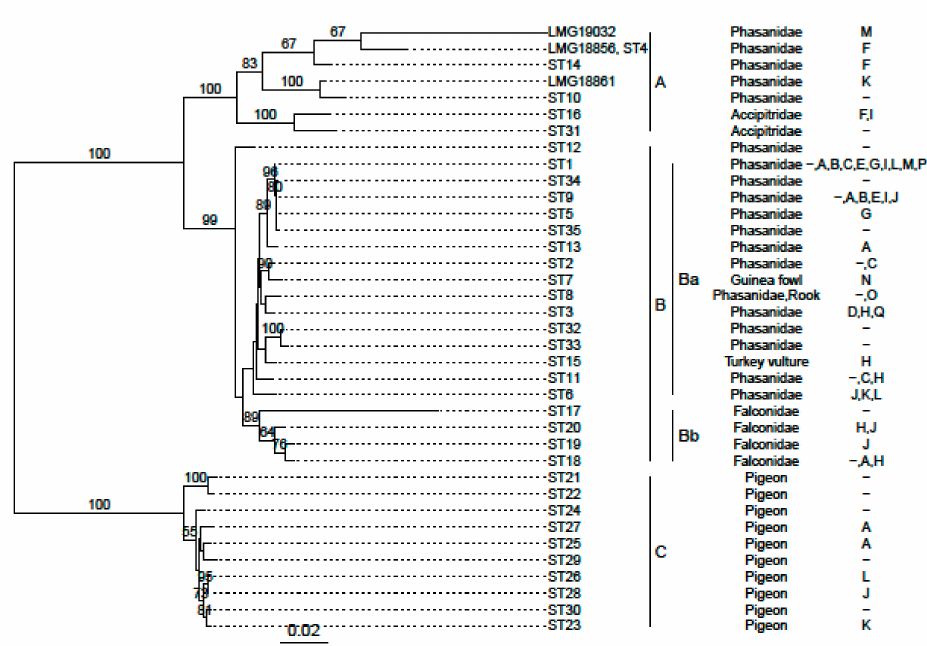
Figure 6. Maximum likelihood tree constructed from the concatenated sequences of the genes used for MLST using RAxML with a general time-reversible model with gamma-distributed rate variation and 1000 bootstraps. Bootstrap values greater than 50 percent are shown on branches. At the tips, either the sequence type (ST) or the strain name is given, followed by the host and the determined serotypes (slight serotype cross-reactions are excluded, for the full list see Additional file S5. Pubmlst). The lines indicate the clusters and sub-clusters described in